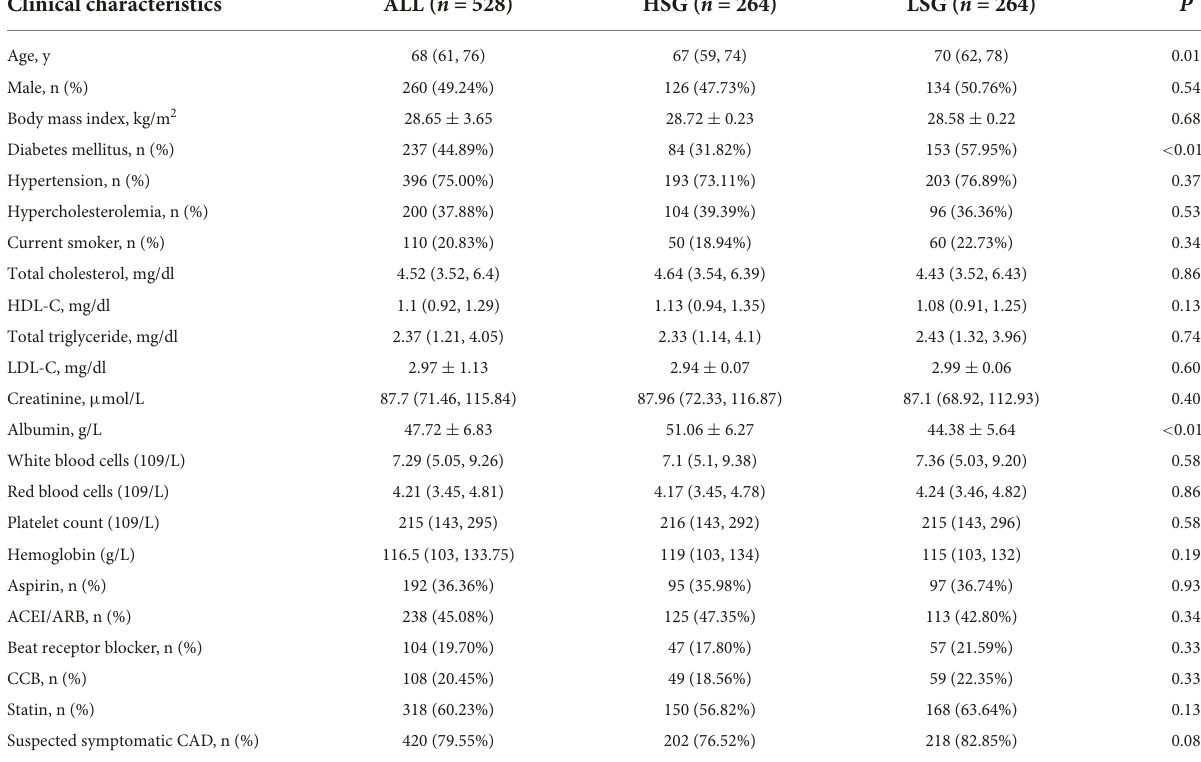
TABLE 1 Differences in baseline characteristics of patients grouped by the median syndecan-1 level. Clinical